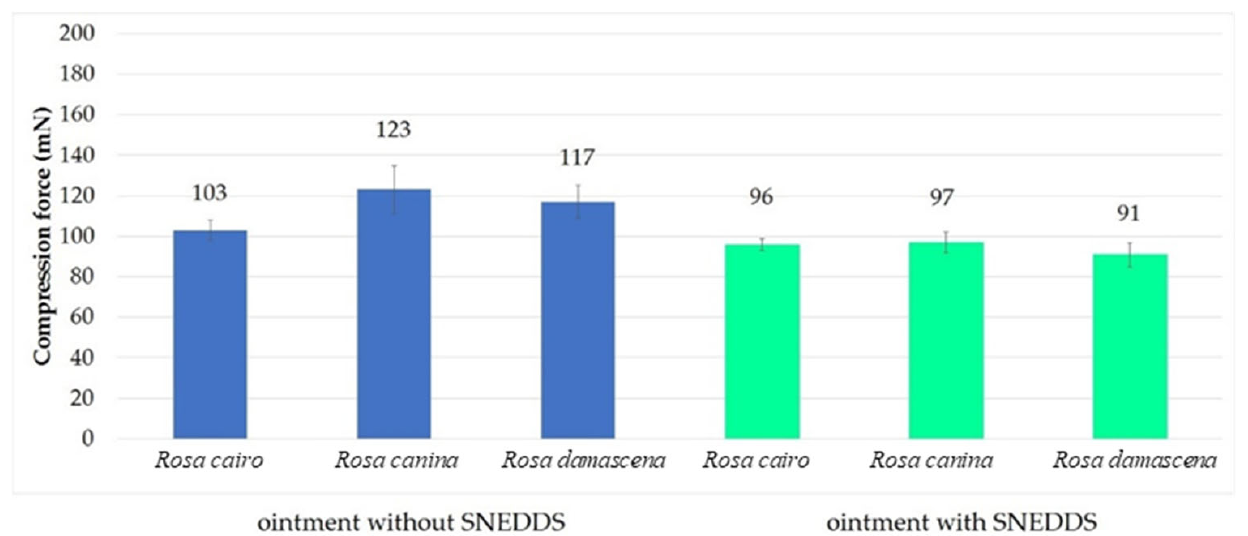
Figure 3. Results of the texture analysis of the formulated ointments with or without SNEDDS.